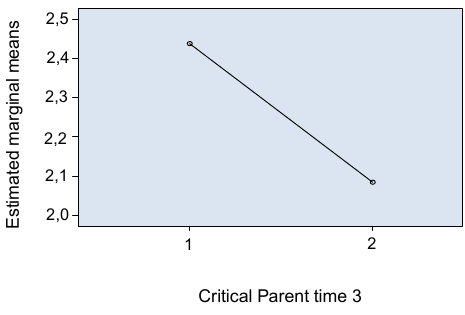
Figure 2: Estimated marginal means of MEASURE 1: